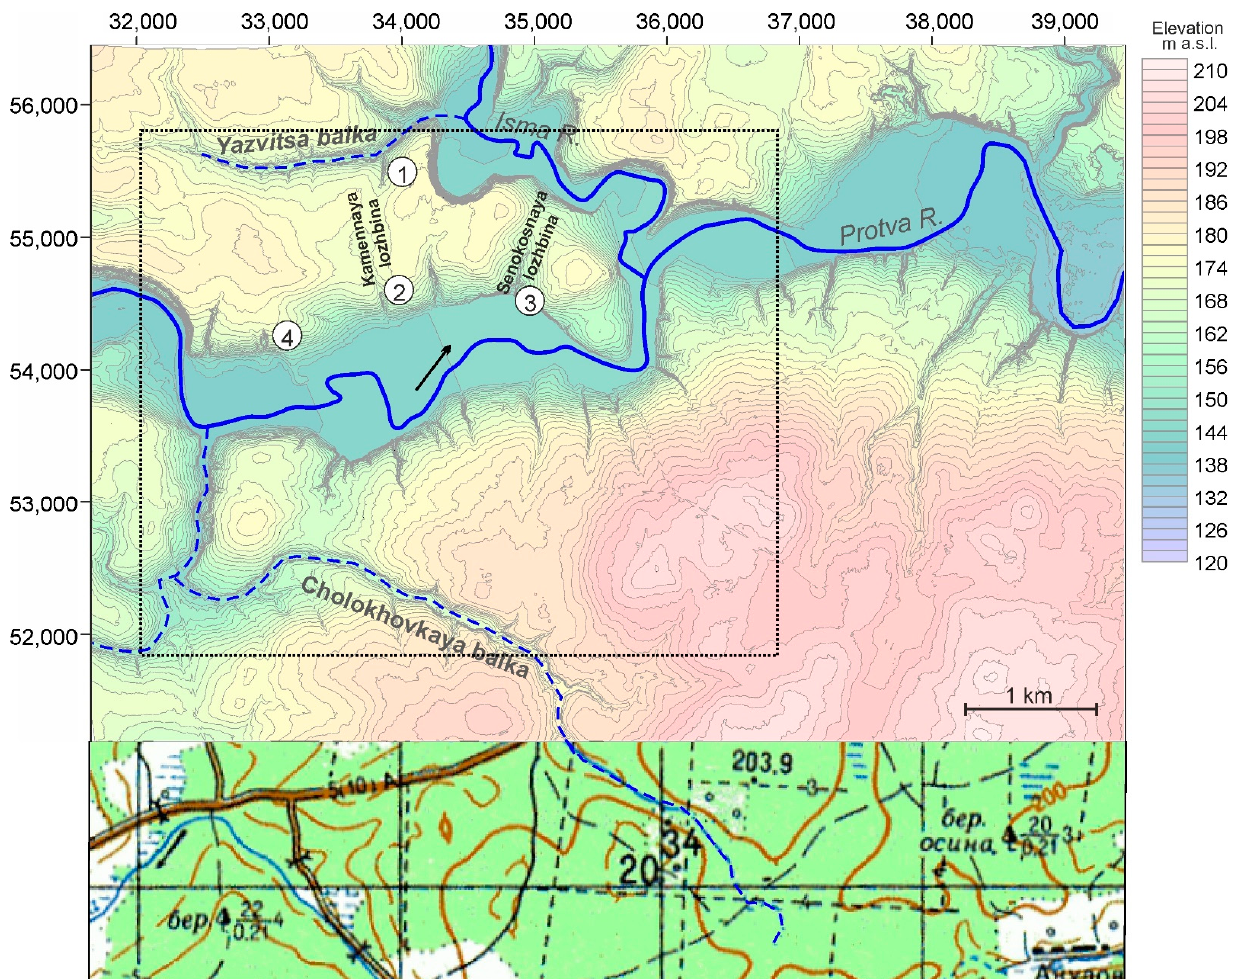
Figure 2. Geomorphological structure of the key area in the Protva River basin. The topography is from Lidar DEM, the southern part is from the topographic map. The numbers indicate positions of the gullies: 1—Uzkiy; 2—Kamenniy; 3—Senokosniy; 4—Volchiy. The dotted box corresponds to the territory in Figure 3.